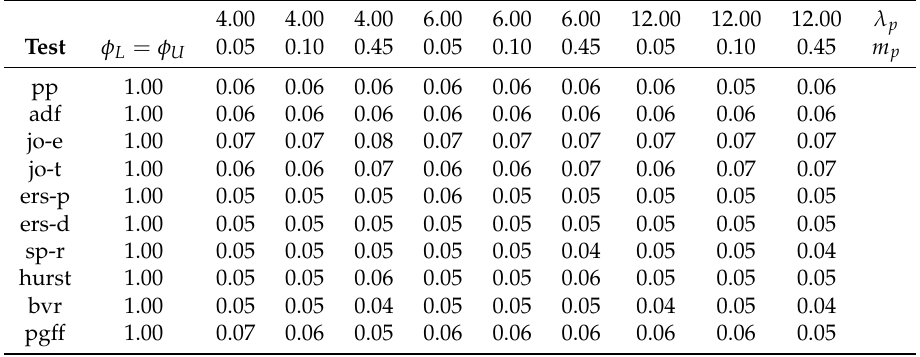
Table 14. Size of cointegration tests for Monte Carlo settings of Type VI (see Subsection 3.4.2).